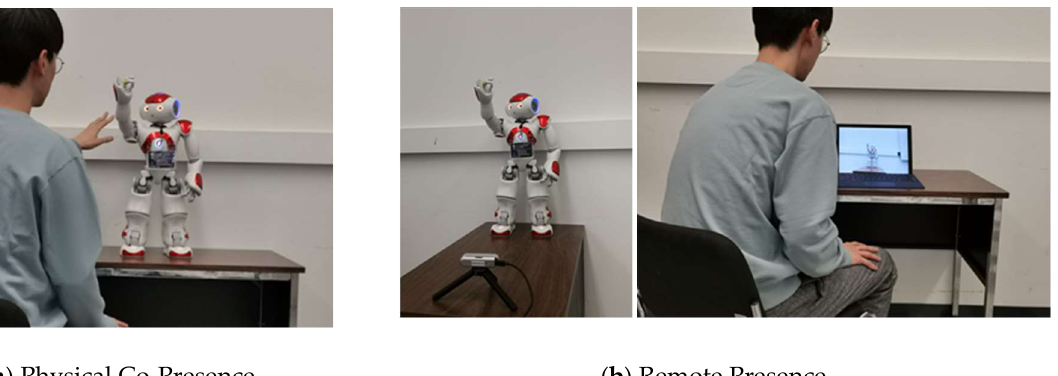
Figure 1. ( a ) In-person HRI scenario, where robot and user are in the same location; and ( b ) Remote HRI scenario, where robot and user are spatially separated in different locations.